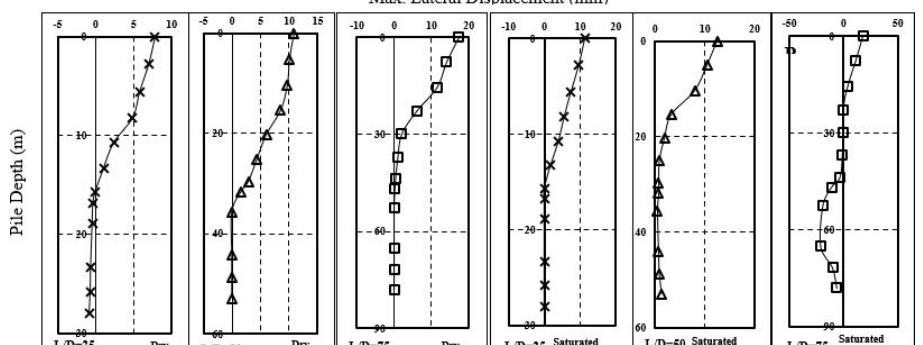
Figure 3: Lateral pile displacement with the depth